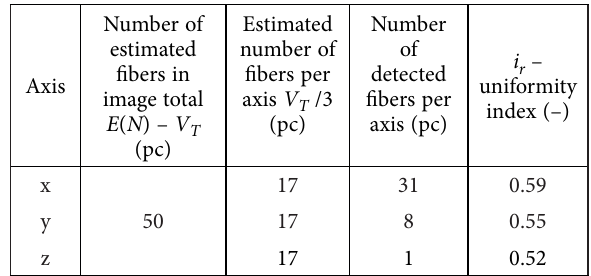
Table 5. Calculation table of partial and total percentage of the